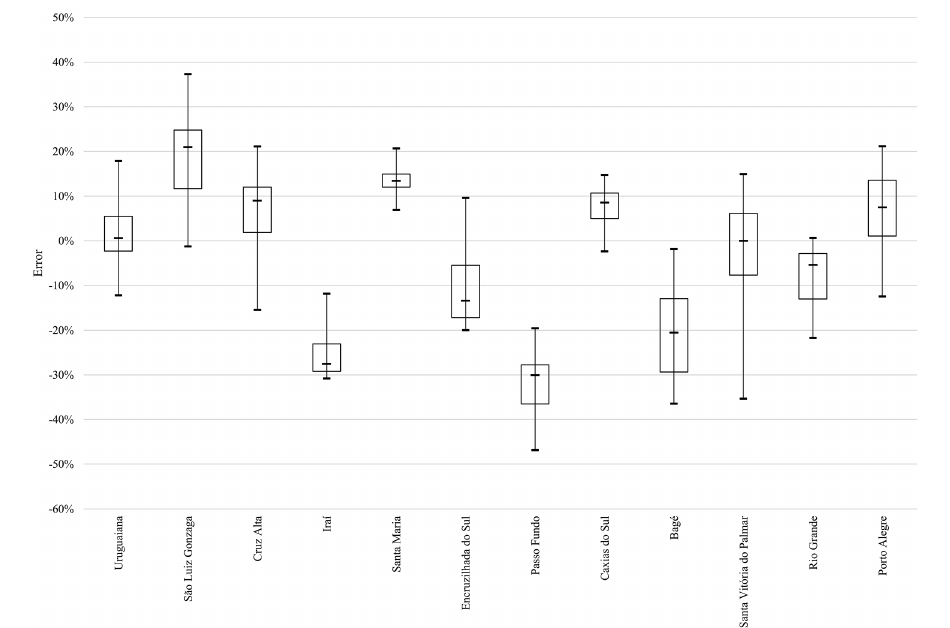
Figure 2. Behavior of IDF, Bell, TRMM and TRMM adjusted set in the North (a) , East (b) , Central/Norteast (c) , West (d) and South Re- gions (e) .